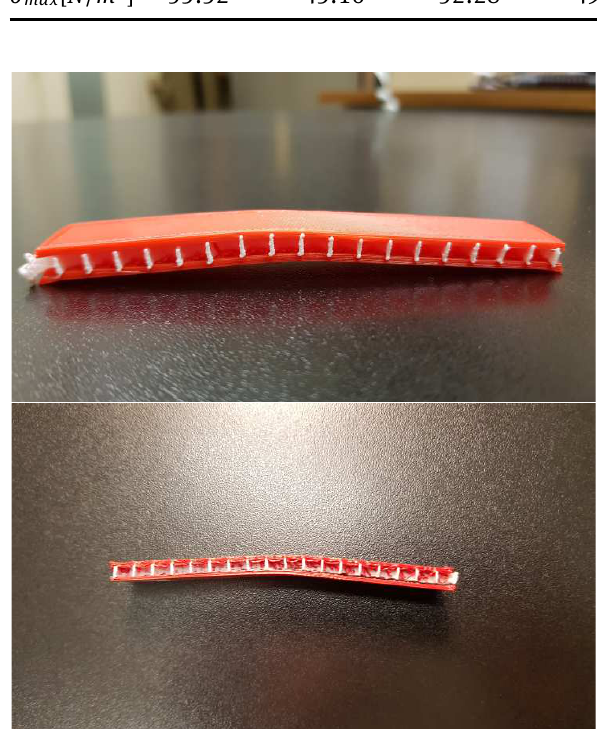
Figure 4: Specimen 7 (on the top) and specimen 8 (on the bottom) after the three-point bending